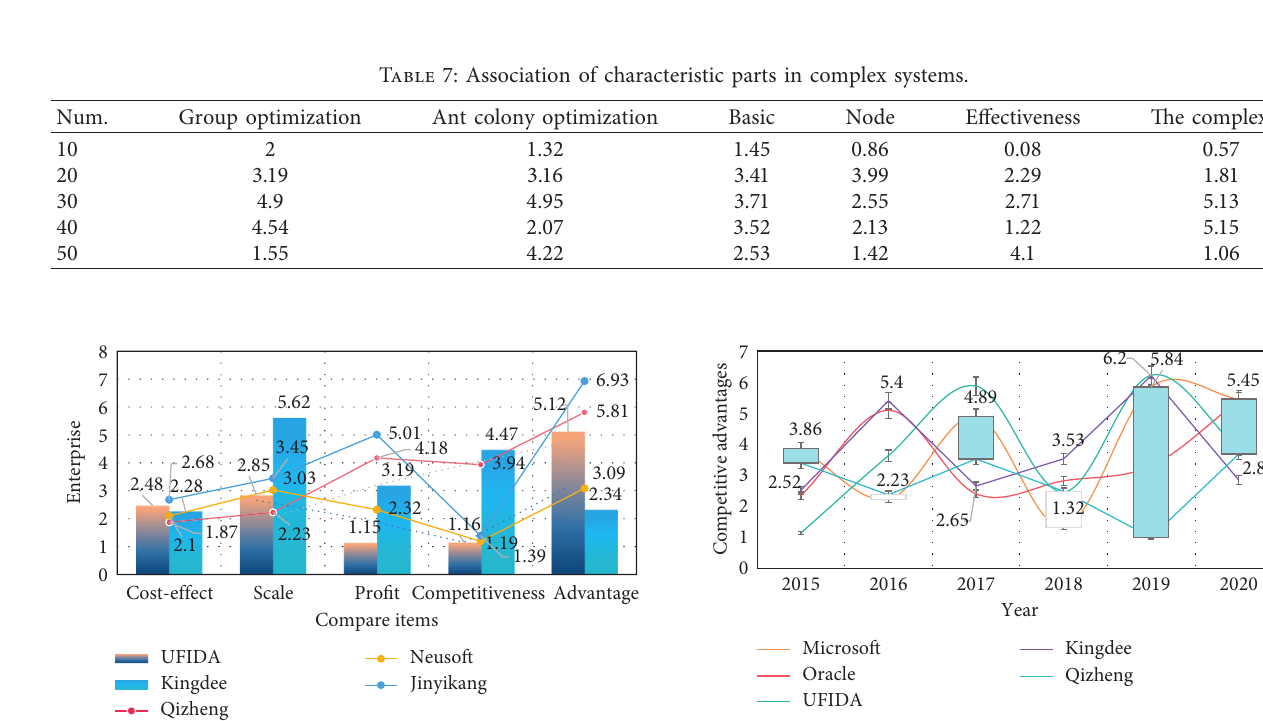
Figure 5: Competitive advantages of different companies. Figure 6: Competitive advantages of Microsoft and